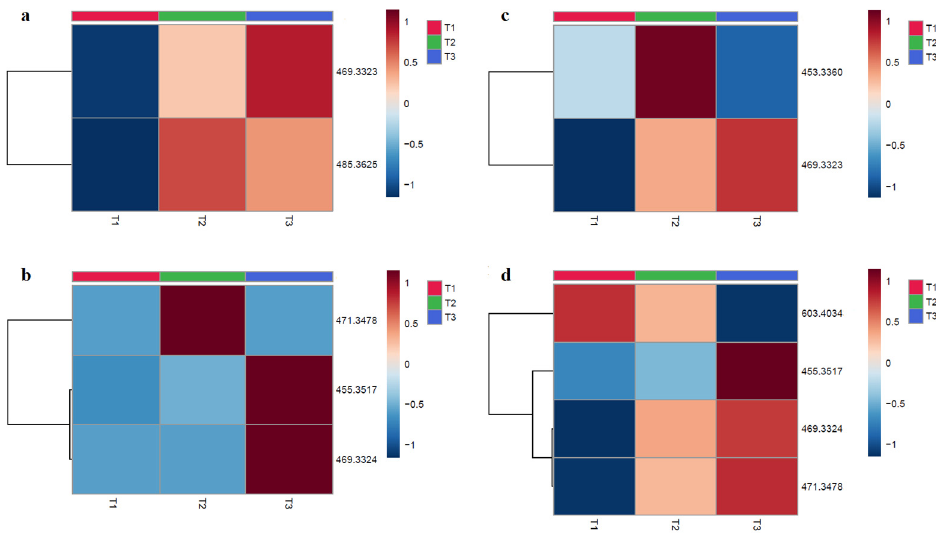
Figure 2. Heatmaps of molecular ions intensity in function of the tested timepoints for 8TTE and UA-3- O -PP. Each column represents an average of three samples (n = 3), and the rows represent a corresponding m/z . (red color = more expressed; blue color = less expressed): ( a ) 8TTE 15 µ M; ( b ) 8TTE = 150 µ M; ( c ) UA-3- O -PP 15 µ M; ( d ) UA-3- O -PP 150 µ M (T1 = 0 min, T2 = 30 min; T3 = 60 min). Analysis was performed using Euclidian distance method with ward clustering algorithm after normalization to sample median and Pareto